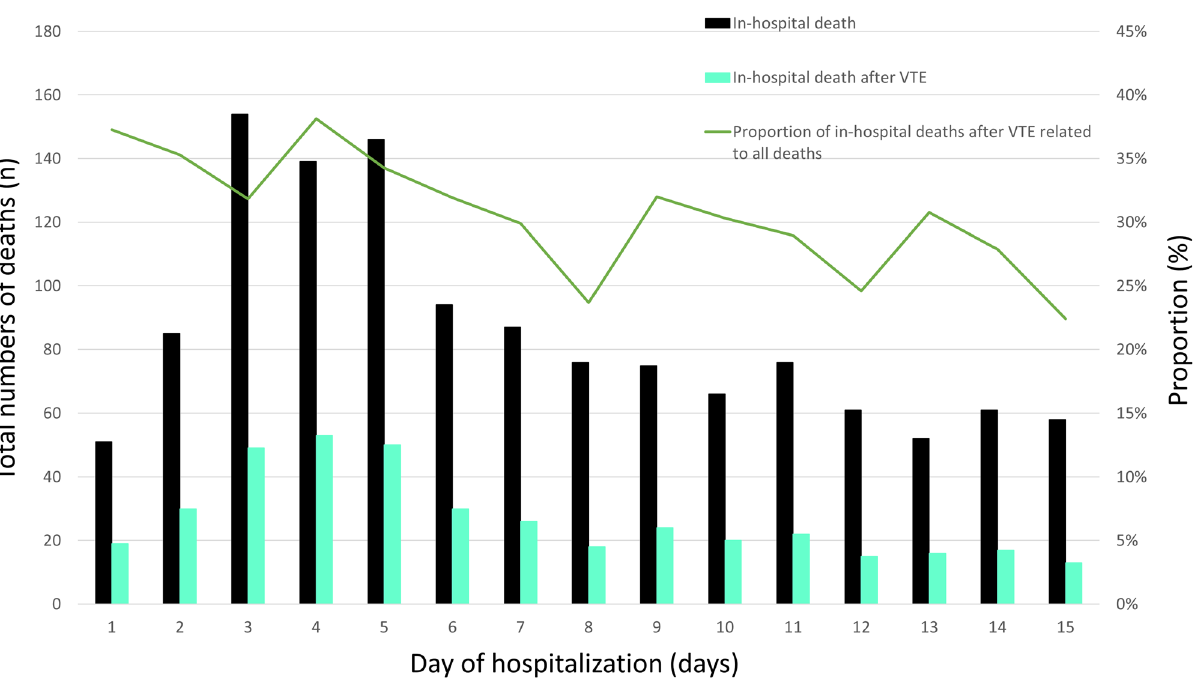
Figure 3. Time trend regarding cumulative number of deaths during the hospitalization period in patients undergoing elective primary KJR in Germany from 2005 to 2016. Total numbers of in-hospital deaths at the different hospitalization days (black bars), in-hospital deaths of patients undergoing elective primary KJR with VTE (green bars) and proportion of deaths in conjunction with VTE. Only the in-hospital deaths of the first 15 days after admission were taken into